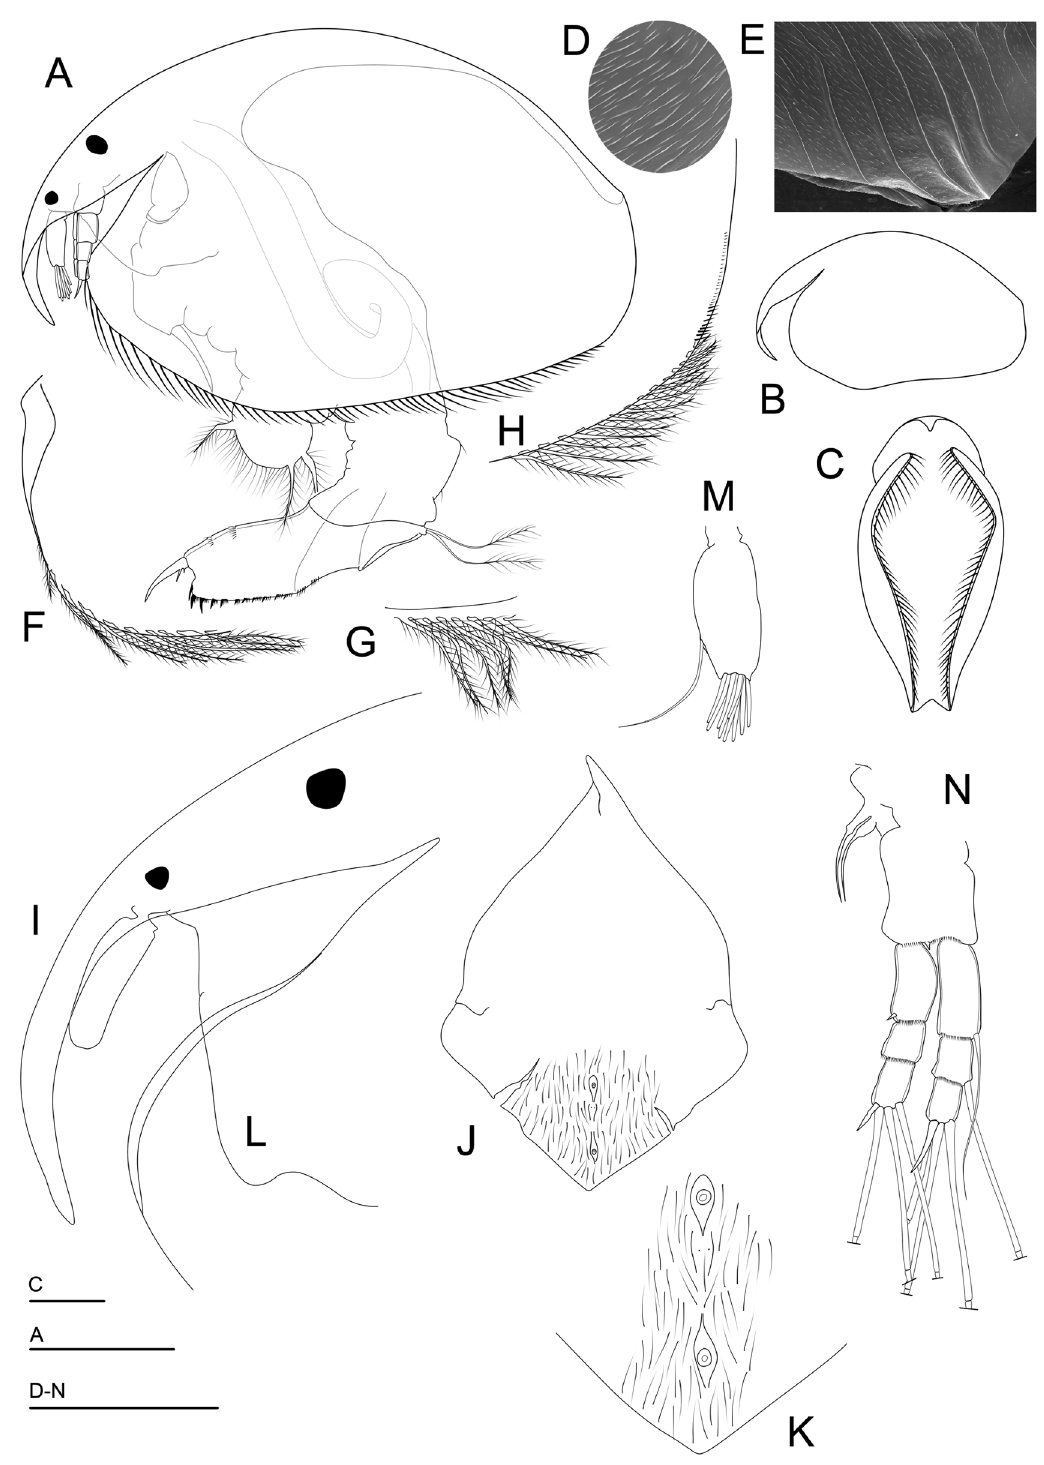
Fig. 7. Disparalona ( Mixopleuroxus ) lucianae sp. nov., parthenogenetic female. A–B . Habitus. C . Ventral view of carapace. D–E . Ornamentation of carapace. F . Anterior portion of ventral margin of carapace. G . Middle portion of ventral margin of carapace. H . Posterior portion and posteroventral corner of carapace. I . Rostrum. J . Head shield. K . Main head pores. L . Labrum. M . Antennule. N . Antenna. Scale bars = 50 μm. Figs B, D–E were not